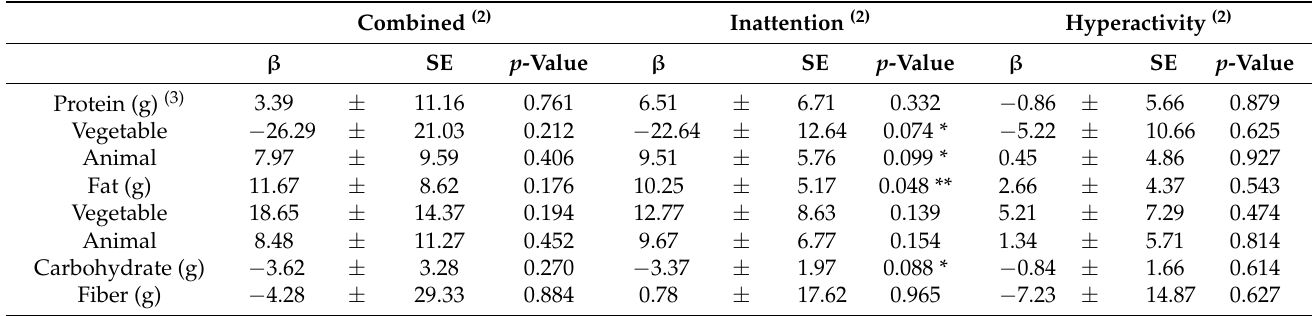
Figure 3. Association between nutrient intakes based on the Phase 2 –Phase 1 intake values and four ADHD groups. Data followed by the same lowercase letter indicate no significant difference at p < 0.05. Table 5 lists the correlation between the nutrient intake (Phase 2 –Phase 1 ) and ADHD scores. Negative correlations were observed between the combined ADHD and vegetable iron ( p = 0.061) and zinc ( p = 0.022). A negative correlation appeared between the AD and vegetable protein ( p = 0.074) and iron ( p = 0.044). In contrast, a positive relationship was observed among the animal protein ( p = 0.099), total fat ( p = 0.048), and AD. In the case of HD, a negative correlation was observed between calcium ( p = 0.057) and zinc ( p = 0.007). Table 5. The correlation of ADHD scores and the differences of nutrients intake measurement (Phase (1) 2 –Phase 1 )